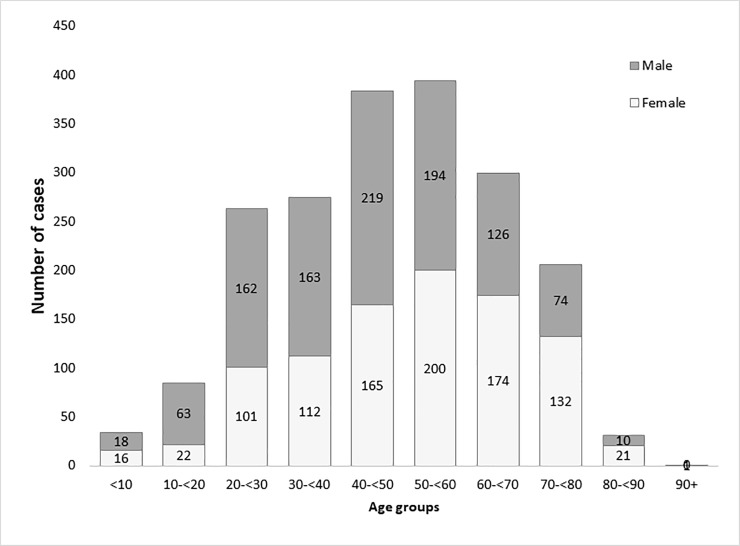
Number of TBE cases per age group and gender.